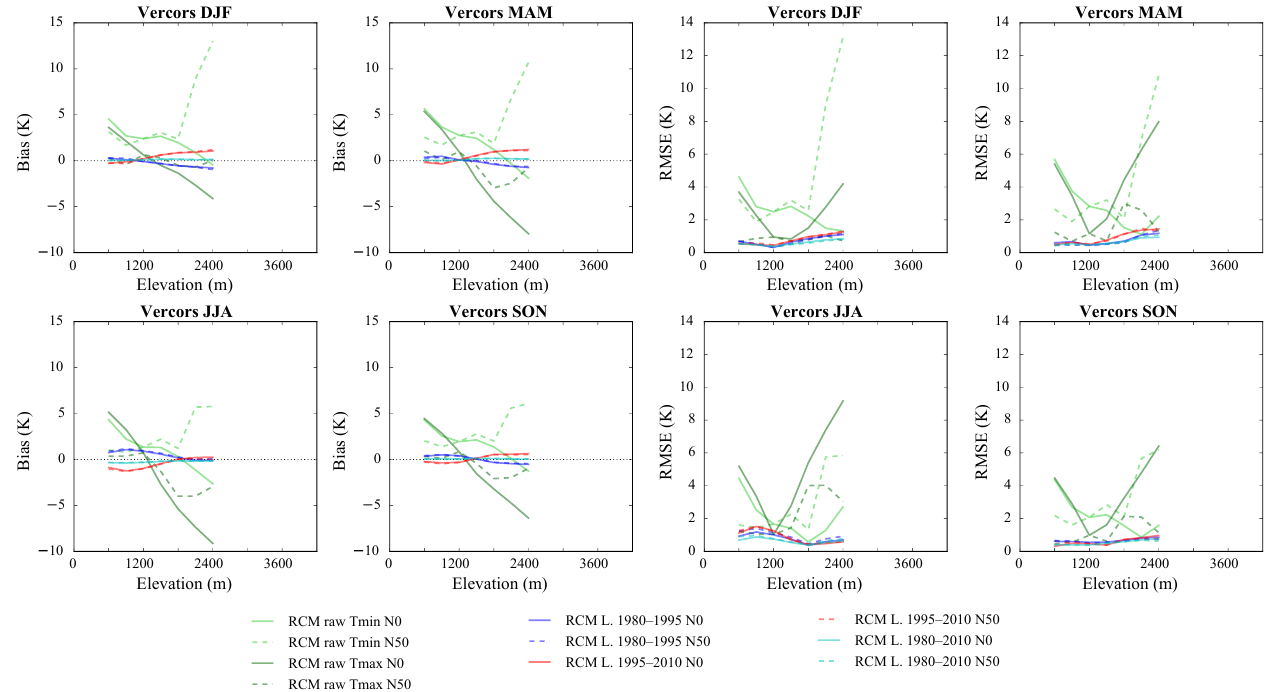
Figure 5. Temperature mean bias and root mean square error (RMSE) of each raw and adjusted RCM simulation compared to the SAFRAN reanalysis over the evaluation period for the Vercors massif as a function of elevation. Scores computed for the raw RCM simulations concern minimum and maximum daily temperatures.